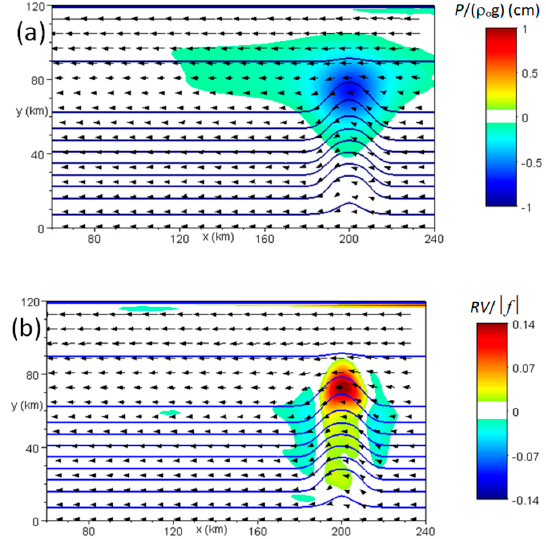
Figure 6. Topographic steering scenario. Near-bottom anomalies of: ( a ) dynamic pressure converted to equivalent sea-surface elevation (cm); and ( b ) relative vorticity in units of | f |, both after 10 days of simulation. Ambient far-field distributions have been subtracted. Solid lines are isobaths. Arrows represent the near-bottom horizontal velocity field. Only every 8th vector is shown.